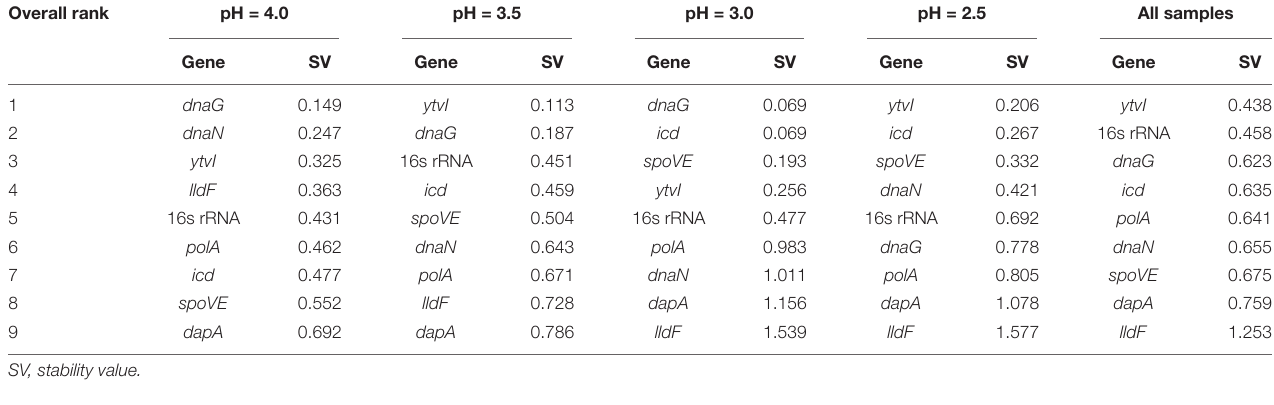
TABLE 3 | Expression stability of candidate reference genes in A. acidoterrestris assessed by NormFinder program. Overall rank pH = 4.0